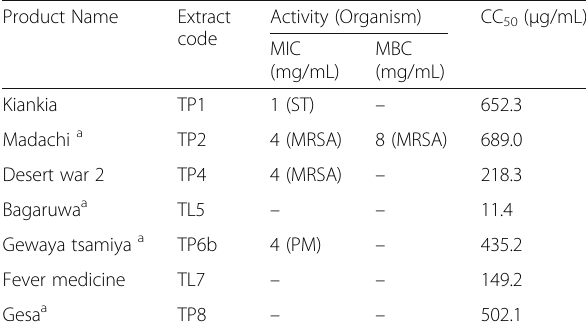
Table 4 MICs, MBC and CC 50 of crude extracts of traditional medicine preparations